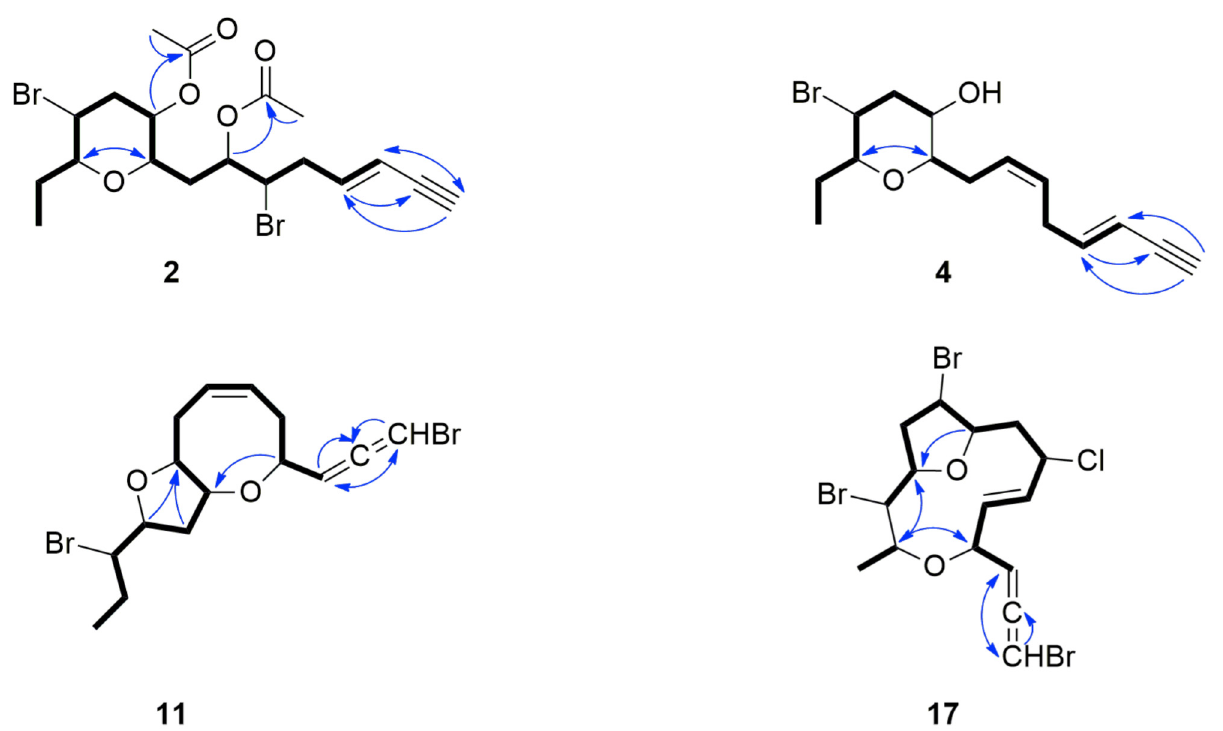
Figure 2. COSY (bold bonds) and important HMBC (arrows) correlations observed for compounds 2 , 4 , 11 and 17